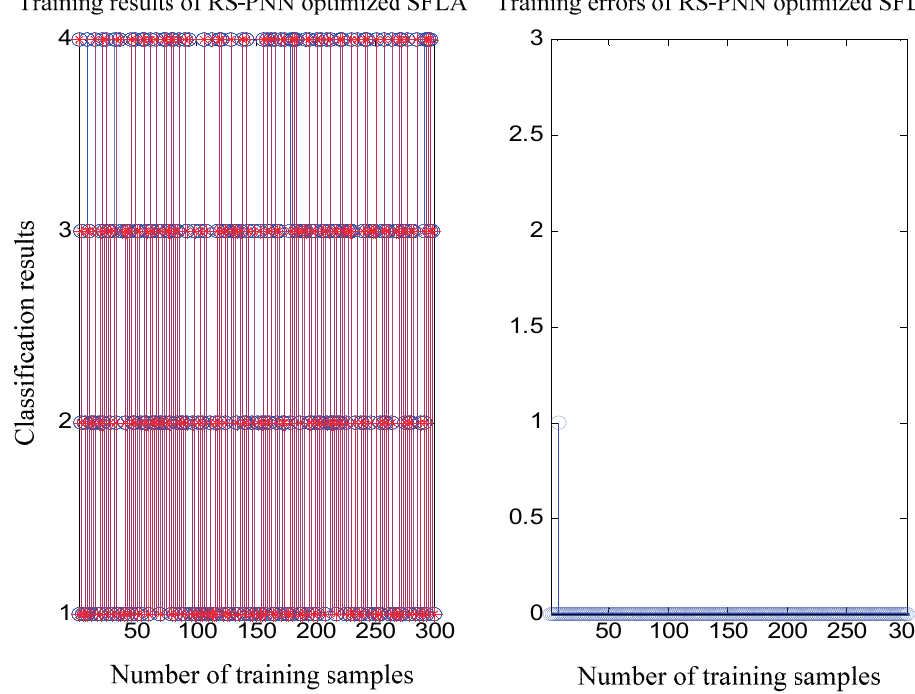
Figure 11. Classification results of RS-PNN optimized by SFLA under training samples.